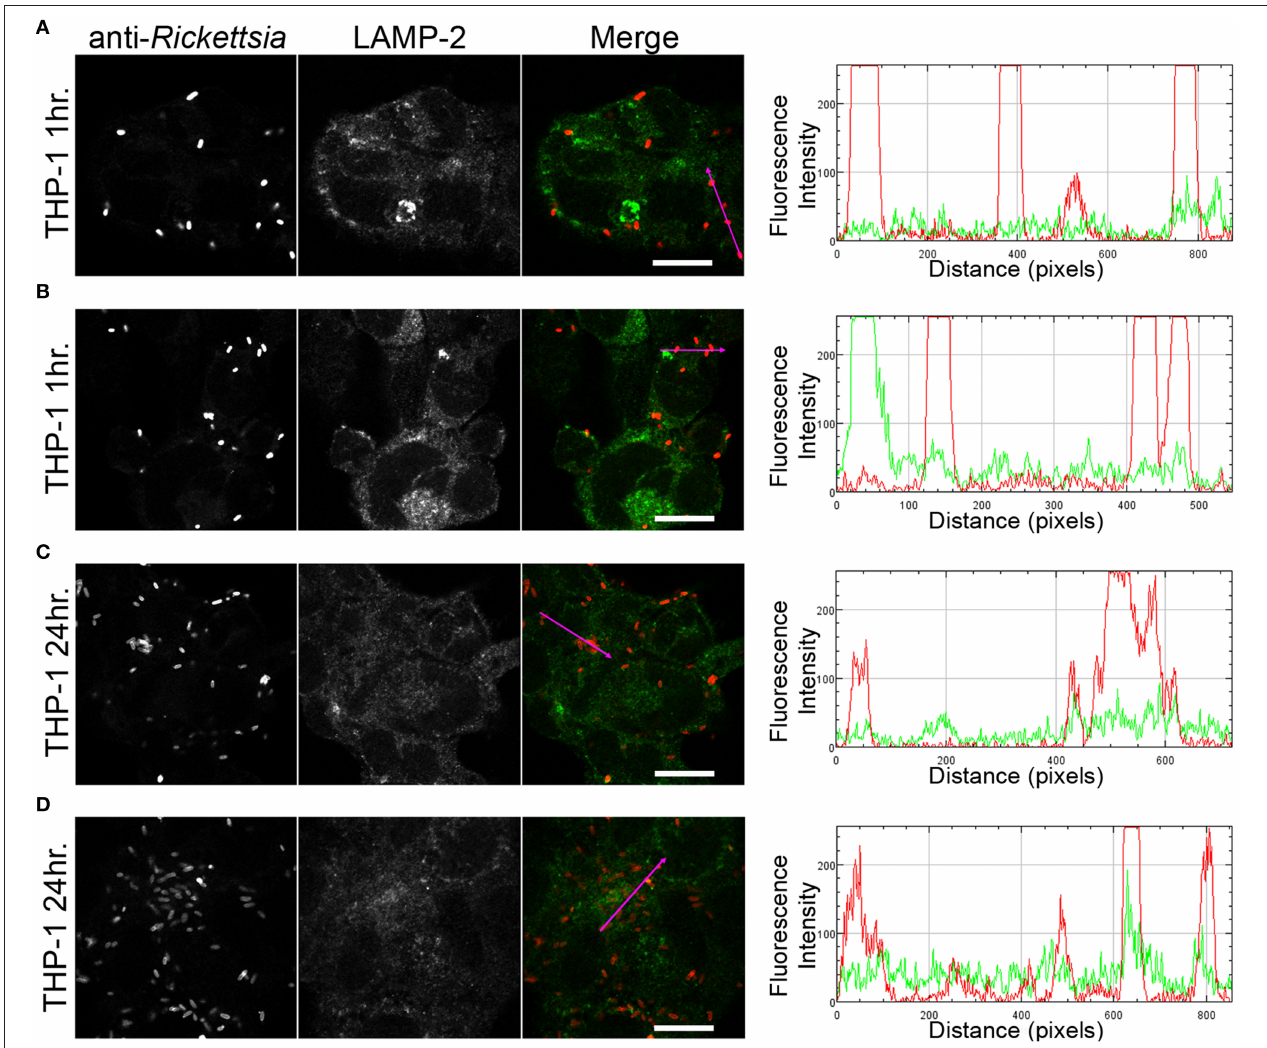
FIGURE 6 | R. conorii is maintained as morphologically intact bacteria in THP-1-derived macrophages. THP-1-derived macrophages were infected with R. conorii (MOI = 10). At 60 min or 24 h post infection, cells were fixed, permeabilized, and double stained for immunofluorescence confocal microscopy analysis with anti-Rc PFA followed by Alexa Fluor 546 (red) to stain R. conorii and the monoclonal antibody for LAMP-2, lysosomal membrane protein followed by Alexa Fluor 488 (green). (A–D) Representative images of a single slice from the z stacks. THP1-derived macrophages at 60 min post infection (A,B) and 24 h post infection (C,D) . Each row shows, from left to right, Rickettsia staining, LAMP-2 staining, the merged image, and a RGB plot profile illustrating the fluorescence intensity along the magenta arrow. Scale bar = 10 µ m. Supplementary Movies 5, 6 represent 360 ◦ rotation movie of the 3D projection of the stack images shown in (A) and (C) ,